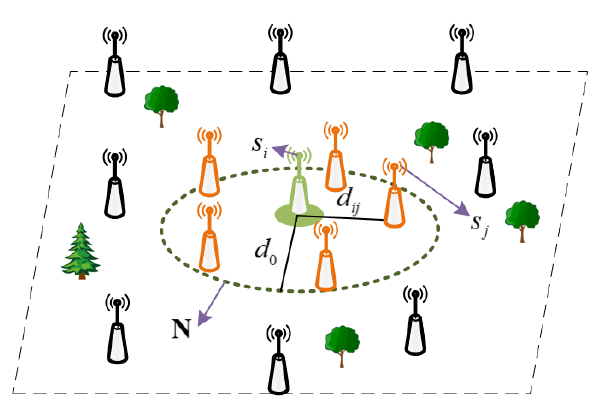
Figure 4. Neighborhood node